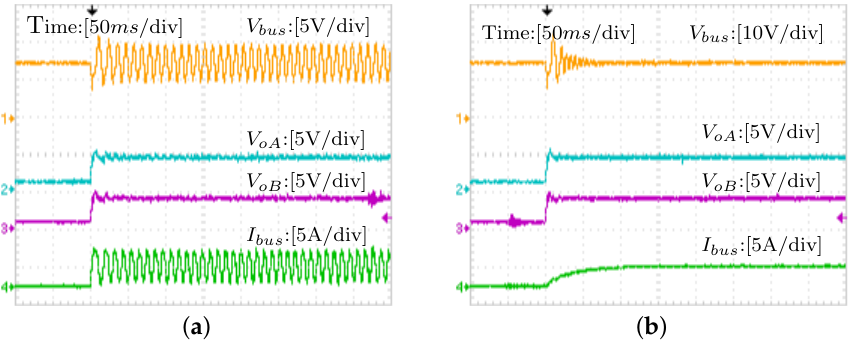
Figure 17. Experimental results of simultaneous switching of Load A and Load B : ( a ) without the proposed controller; and ( b ) with the proposed